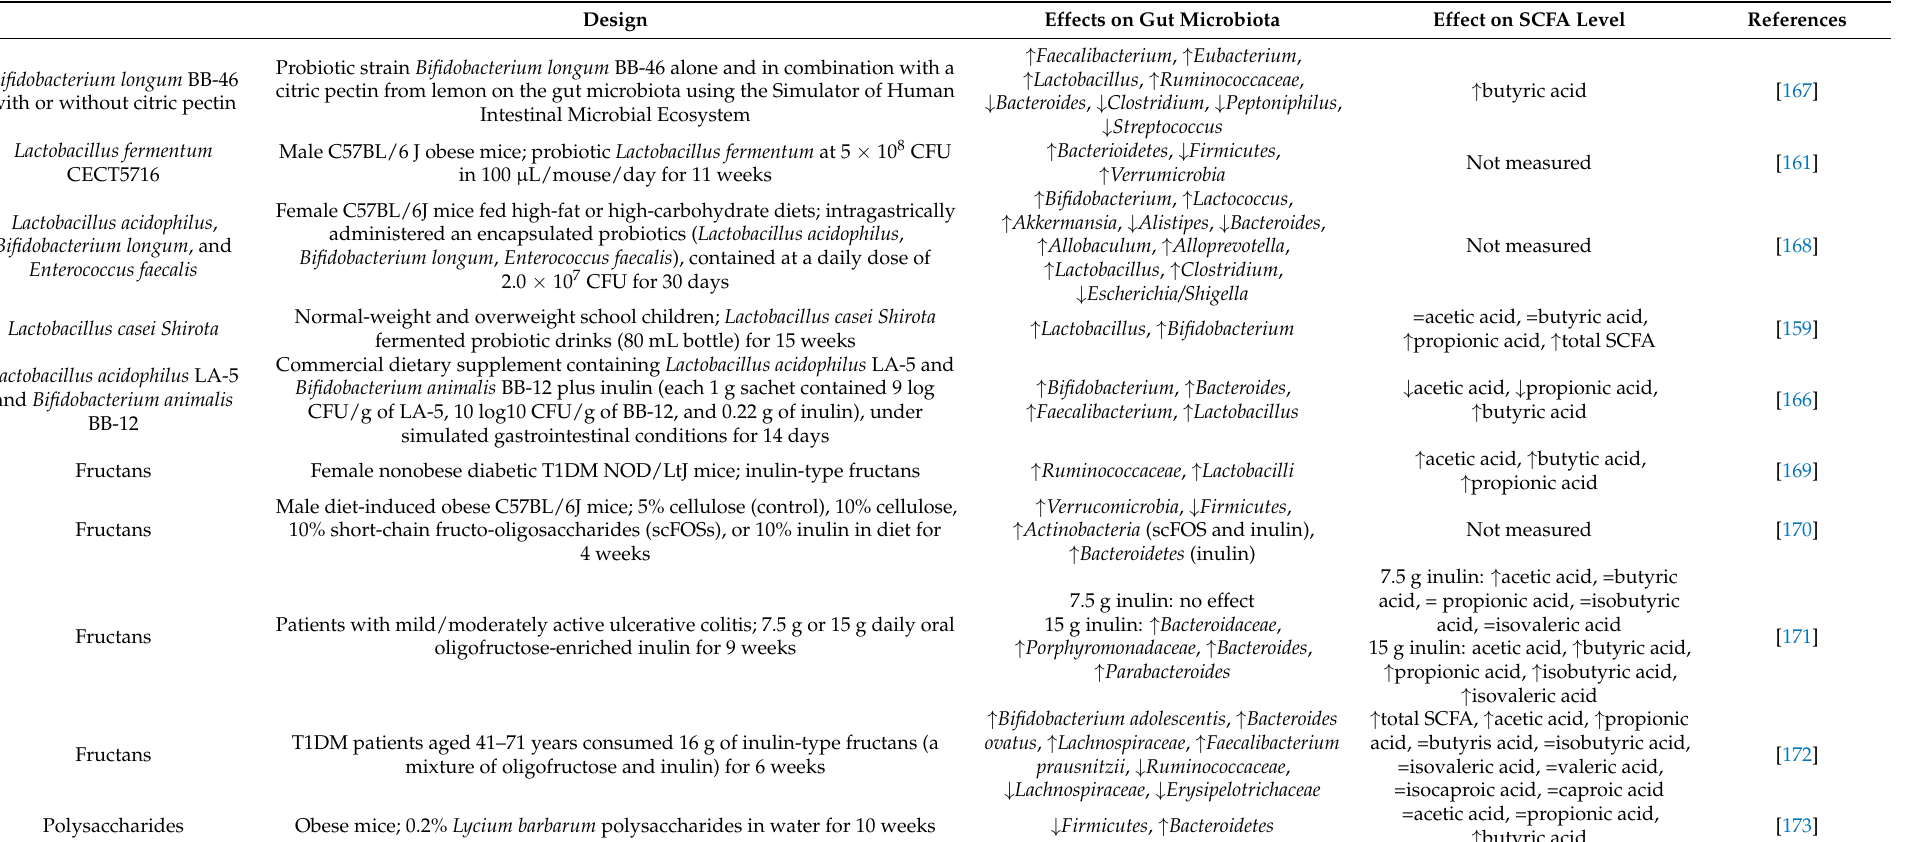
Table 3. Influence of prebiotics, probiotics, and synbiotics on the gut microbiota